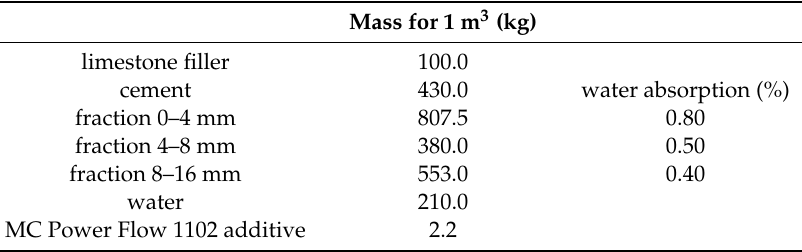
Table 2. Concrete Table 2. Concrete composition.